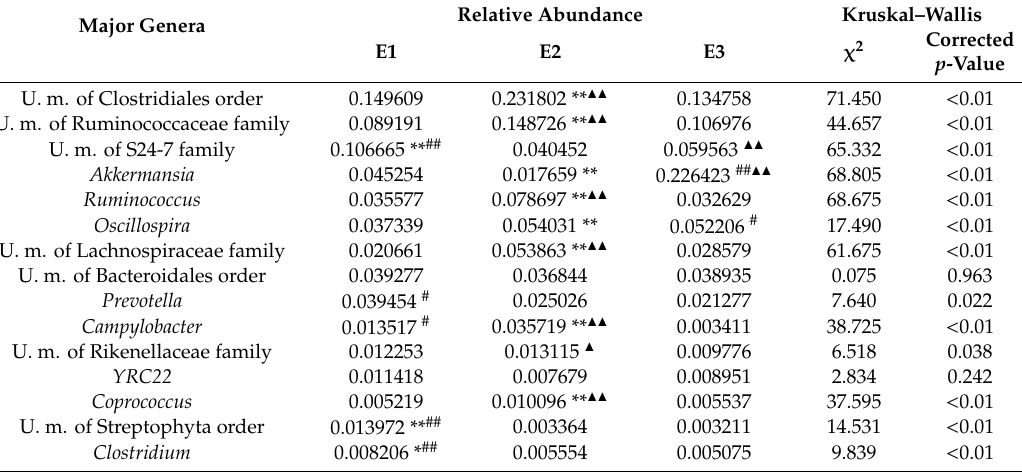
Table 1. Average relative abundances of the major genera (top 15) among the three enterotypes. p -values had been corrected using the false discovery rate control. All pairwise analysis of the Kruskal–Wallis test was used for post hoc multiple comparisons and significant di ff erences were denoted as: E1 vs.